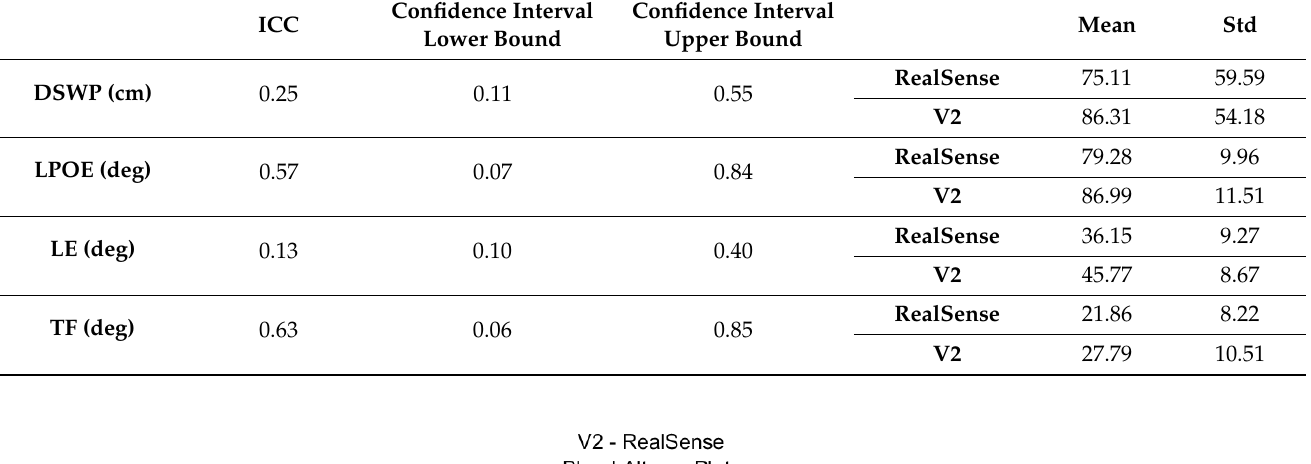
Table 4. Inter-rater reliability ICC 2,1 between RealSense and V2.